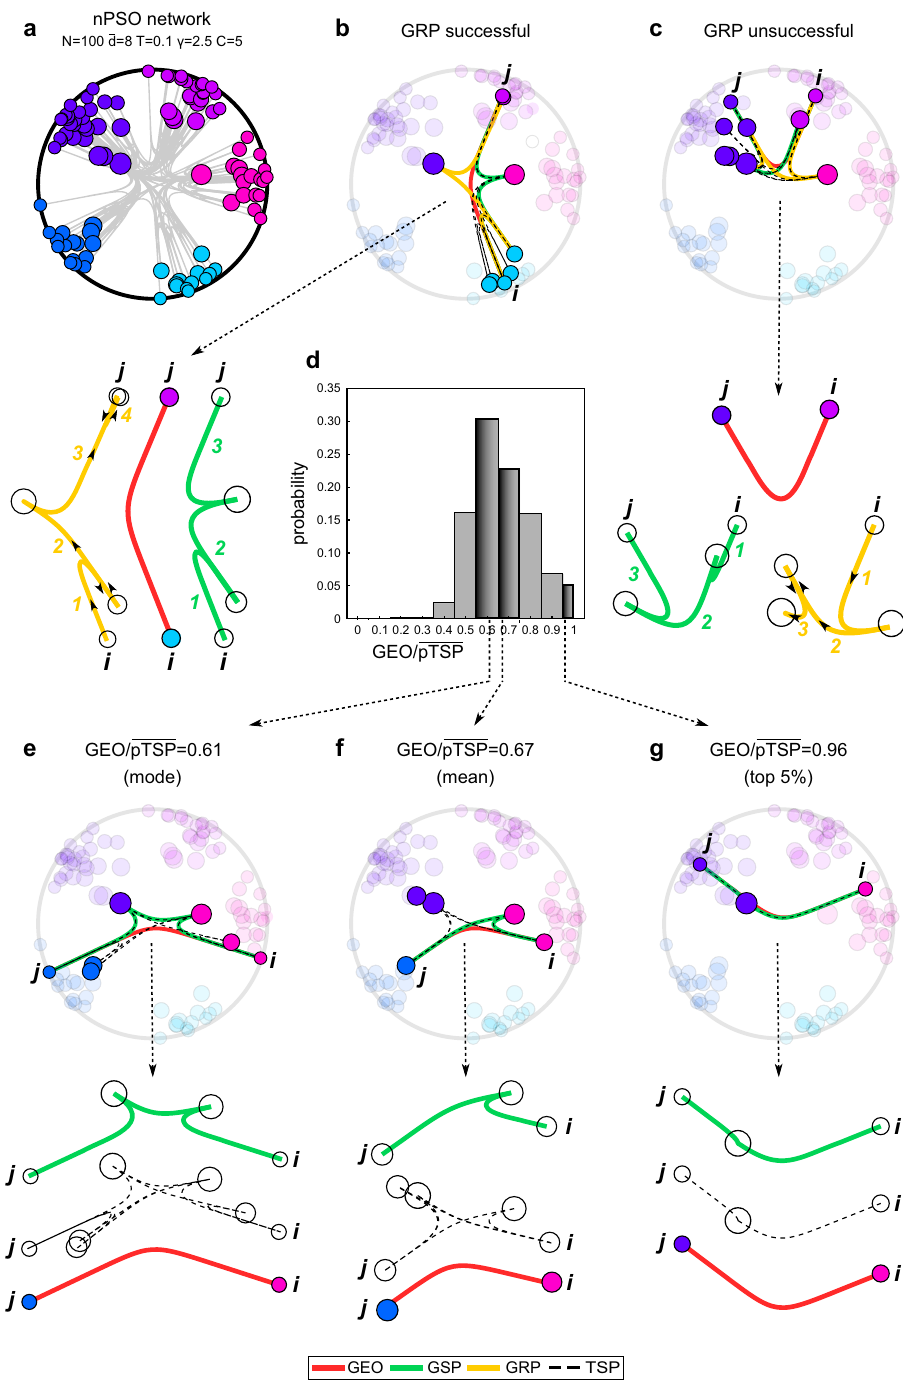
Fig. 1 | Visualization of the different types of paths in the geometrical (hyper- bolic)space. A nPSO network hasbeen generated with parameters N = 100, (cid:1) d = 8, T = 0.1, γ = 2.5 and C = 5. a Representation of the nPSO network in the native disk representationofthe hyperbolicspace: the linksareingrey colour andfollow the hyperbolic geodesics, the nodes are colored by community membership and their size is proportional to the logarithm of the degree. b The panel highlights the hyperbolic geodesic (GEO, red), the geometrical shortest path (GSP, green), the greedy routing path (GRP, yellow with arrows of directionality) and the hyperboliclinksinvolvedinallthe possibletopologicalshortestpaths(TSP,black dashed) between two speci fi c nonadjacent nodes in the network ( i and j ), char- acterized by a successful GRP. The exploded-view representation (on the left) of